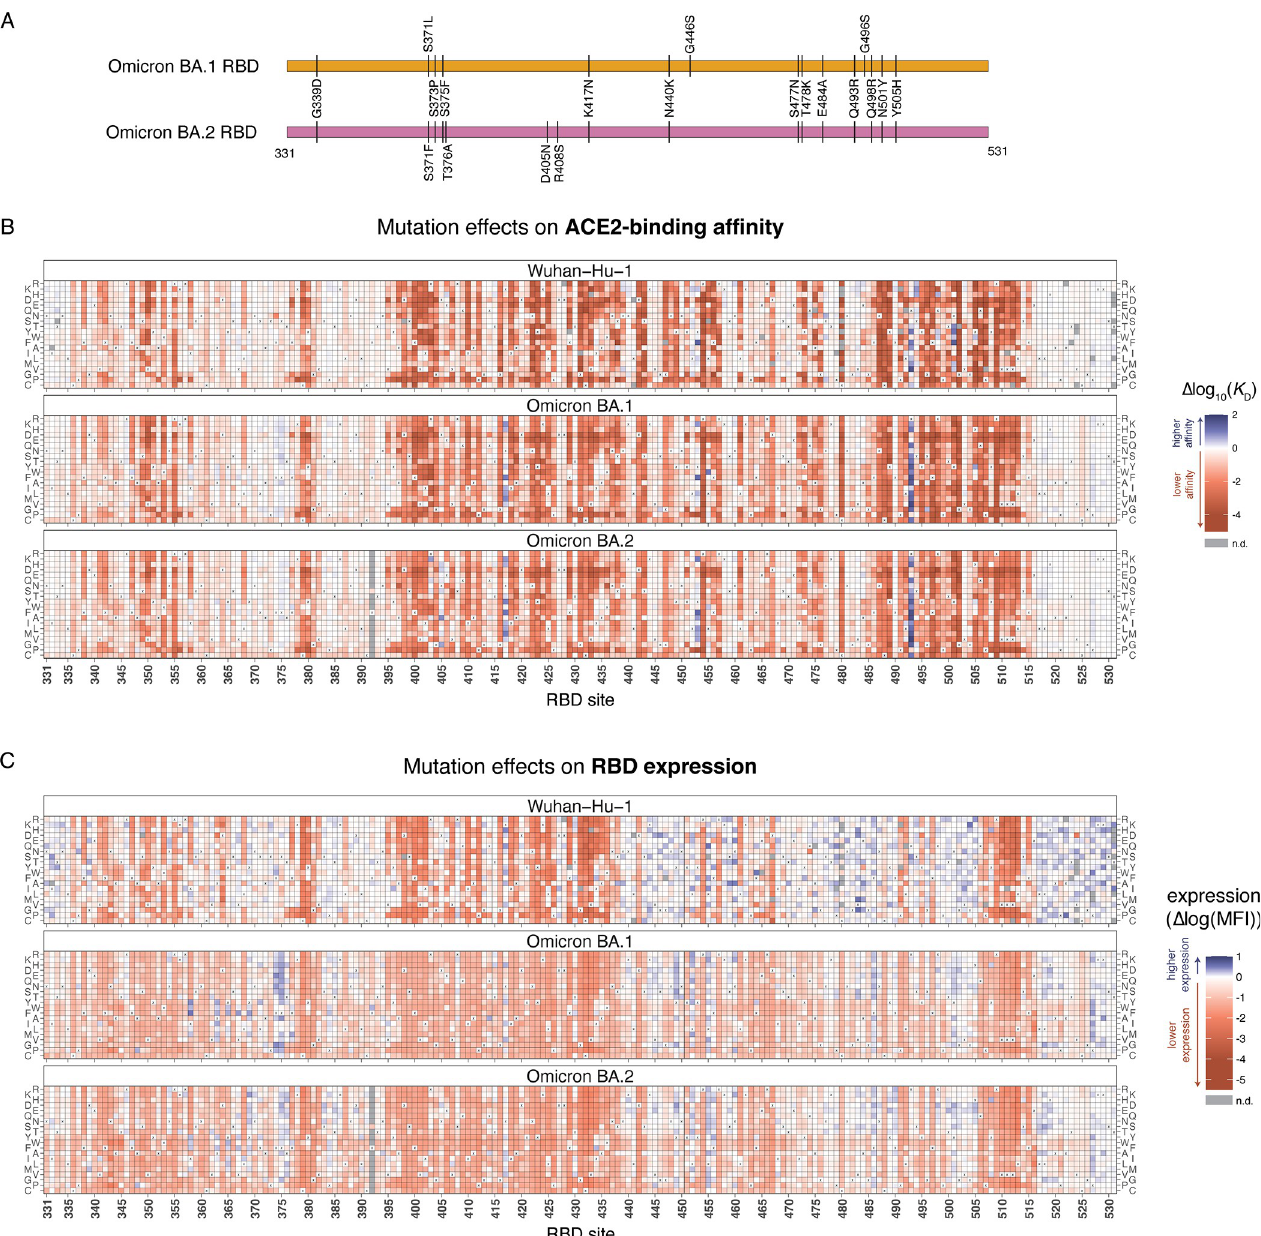
Fig 1. Effects of mutations in Omicron BA.1 and BA.2 receptor-binding domains on ACE2-binding and RBD expression. (A) Diagram of the RBD substitutions that distinguish Omicron BA.1 and BA.2 from Wuhan-Hu-1. We use Wuhan-Hu-1 spike numbering throughout. (B, C) Heatmaps illustrating the impacts of all single mutations on ACE2-binding affinity (B) and RBD surface expression (C), as determined from FACS-seq assays on yeast-displayed RBD mutant libraries. See S1–S3 Figs. for experimental details. Individual measurements are reported in S1 and S2 Data, and an interactive version of these heatmaps is available at https://jbloomlab.github.io/SARS-CoV-2-RBD_DMS_Omicron/RBD-heatmaps/.